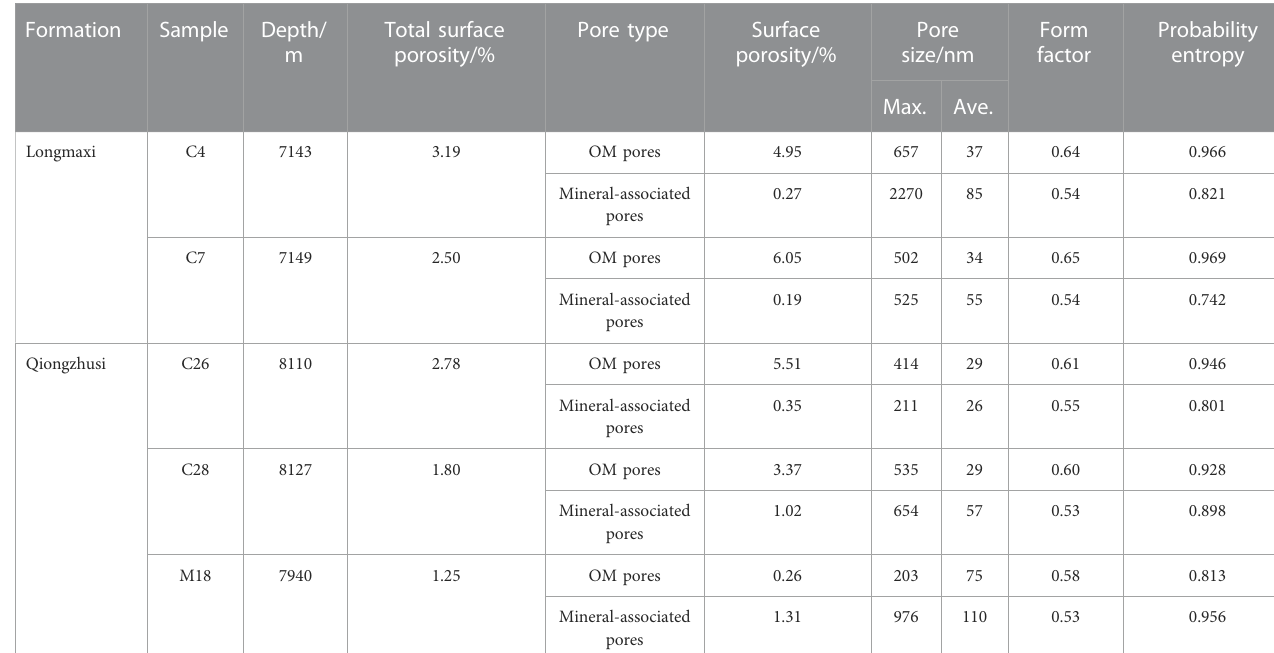
TABLE 1 PCAS processing